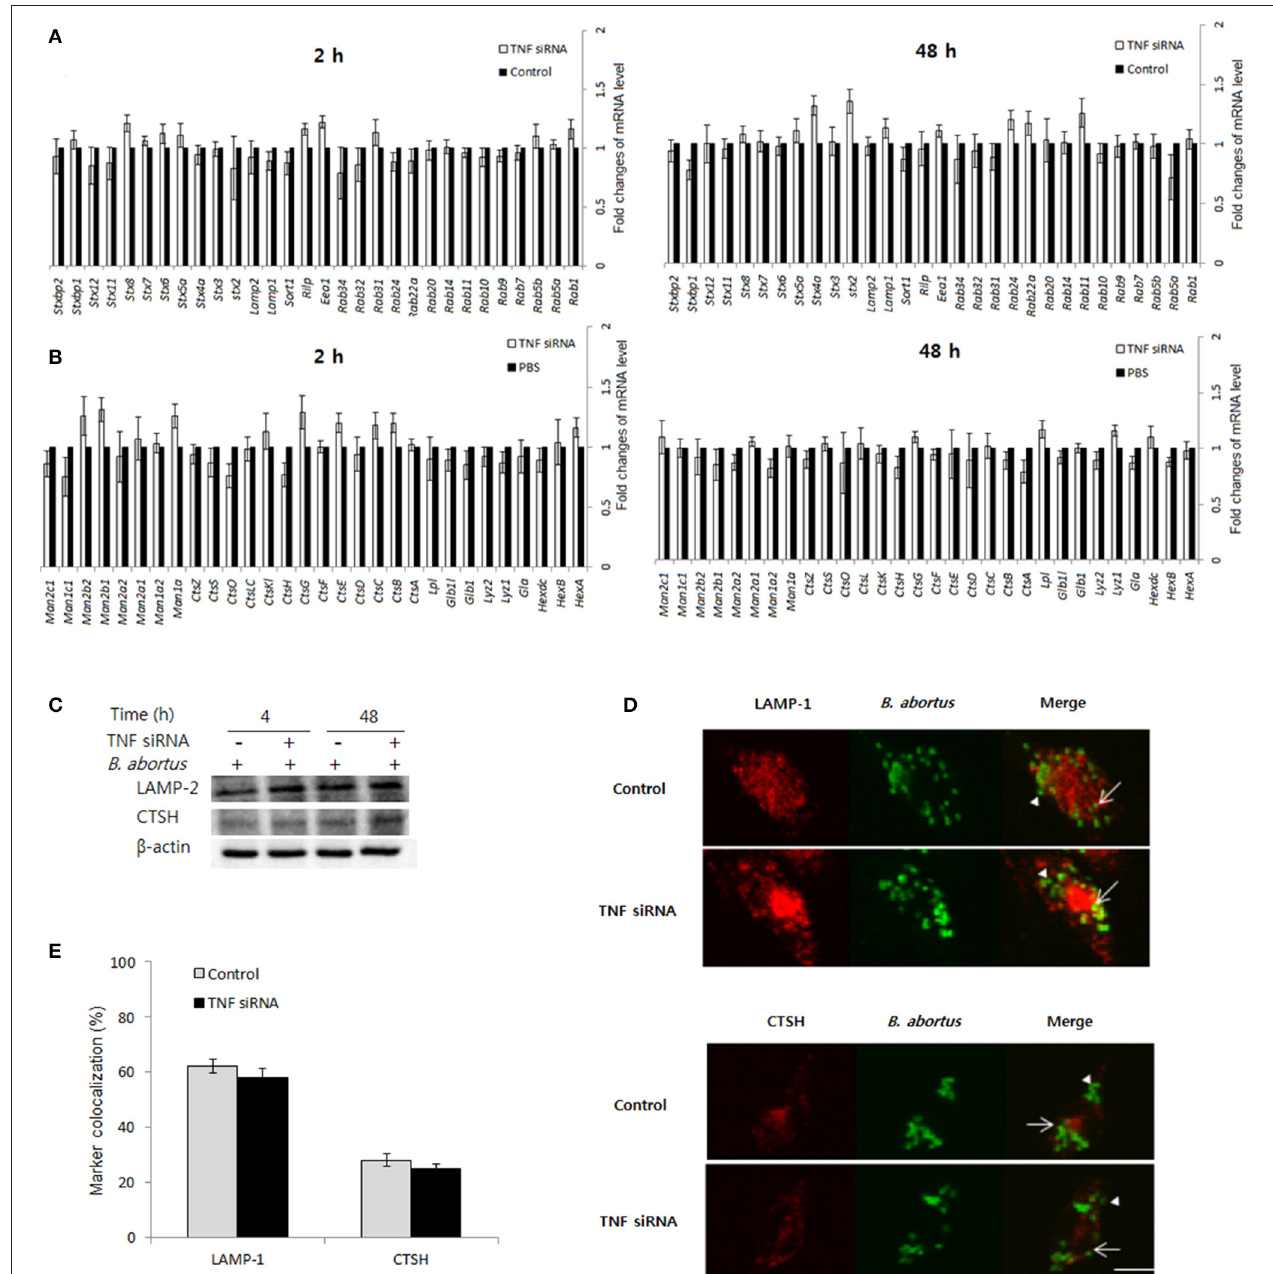
FIGURE 4 | The protective immune responses activated by TNF/TNFR-1 are independent with phagolysosome fusion. Macrophages were treated with TNF siRNA prior to B. abortus infection. The total RNA content was isolated, and the expression levels of representative trafficking regulators (A) and lysosomal enzymes (B) were evaluated by qRT-PCR at 2 and 48h pi. The total protein extracts were also collected and the expression of representatives was examined by Western blot at 2 and 48h pi (C) . The colocalization of BCPs with LAMP-1 and CTSH was analyzed at 2h pi (D) . Marker positive (arrows) or negative bacteria (arrow heads) were visualized by fluorescence microscopy. The percentage of marker colocalized with BCPs in 100 cells was determined (E) . Data represent the mean ± SD of triplicate experiments. Scale bars = 5 µ m.